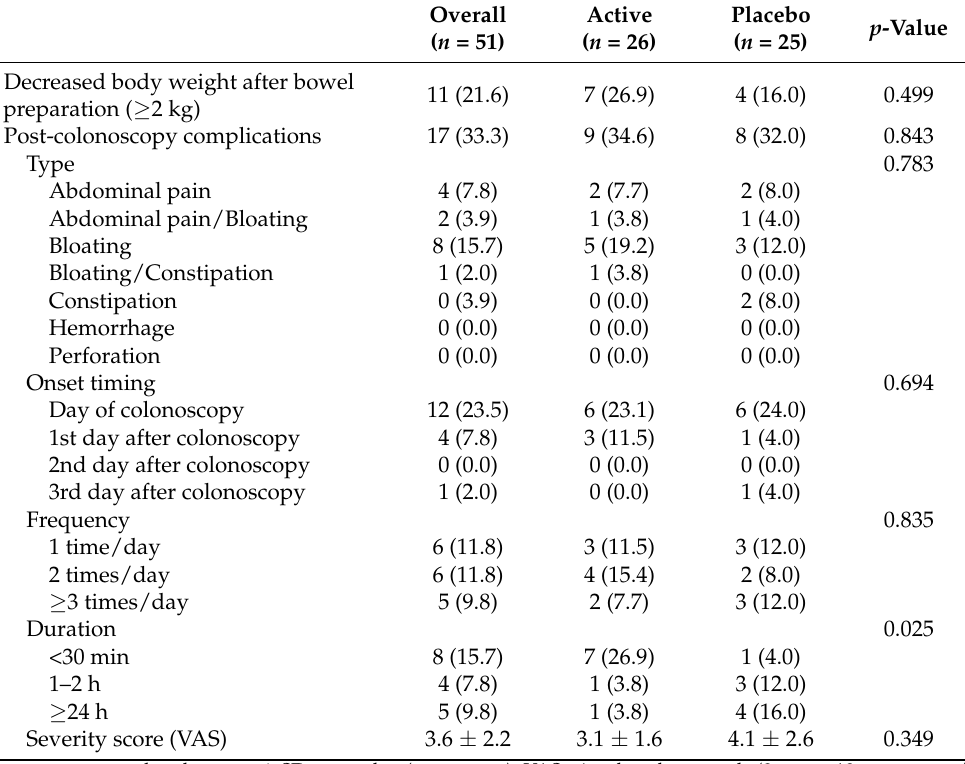
Table 2. Post-colonoscopy